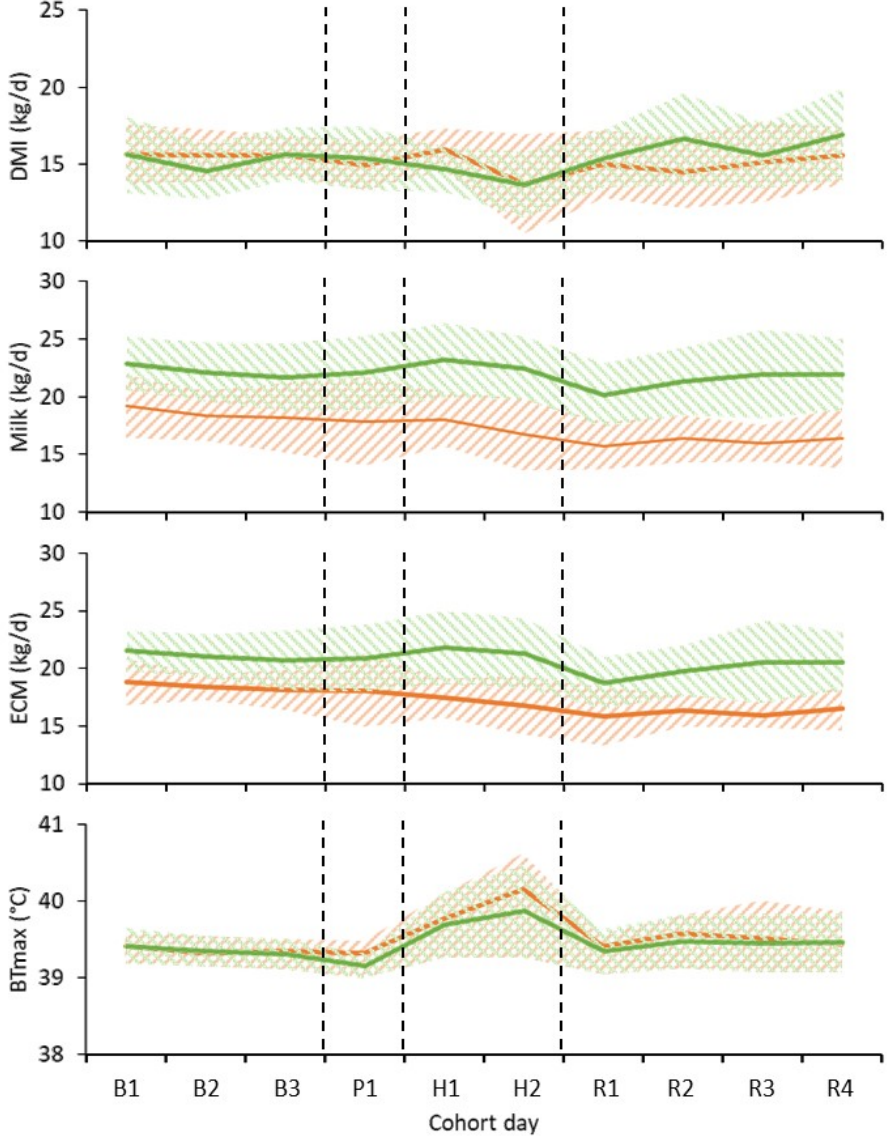
Figure 3. Mean daily dry matter intake (DMI), milk yield (Milk), energy-corrected milk yield (ECM) and maximum vaginal temperature (BTmax) of cows offered chicory (green line) or pasture silage (orange line) during the base period (B), pre-challenge (P), heat challenge (H), and recovery period (P). Each band shows ± one standard deviation from the forage-type mean. The pre-challenge and heat challenge were generated in controlled-climate chambers. Cows were in ambient conditions at other times.